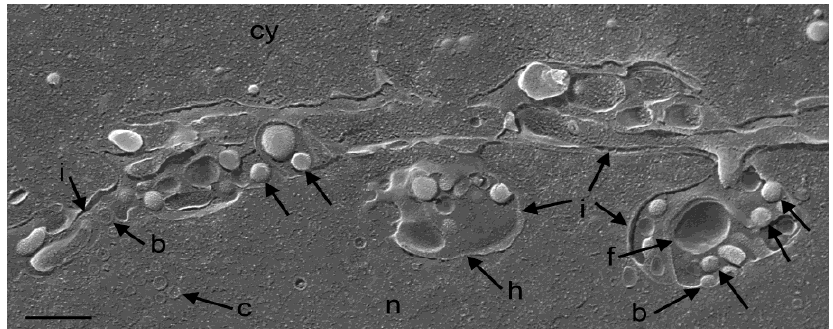
Figure 3. Cryo-FESEM of a R7041(∆Us3) infected Vero cell (12 hpi) showing a fracture plane through the nucleus (n) and the cytoplasm (cy). The INM (i) formed invaginations from which folds (f) arise. Membranes of herniations (h) continue into the INM. Capsids (c) bud (b) at the INM. Virions (arrows) are in invaginations and in the PNS. Bar = 500